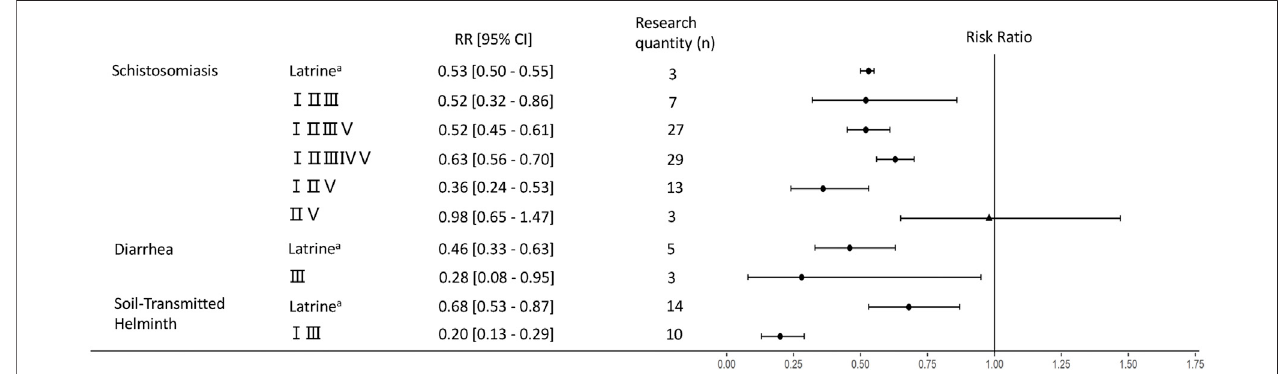
FIGURE 4 | Forest plot for latrine improvement and other interventions. Note: a indicate measures of latrine improvement; I – V correspond to the code of the intervention classi fi cation shown in Table 1 ; the fi gure shows the RR value when these measures are combined with latrine improvement measures; I refers to population-leveldiseasecontrol,IIreferstoanimalreservoircontrol,IIIreferstowatersupplyimprovements,IVreferstoagriculturalandforestrymeasures,andVrefersto othercomprehensive environmental improvement measures; round dotsin the fi gure indicate that themeasure isaprotectivefactor, and triangles indicatethat the statistical test of the measure is not signi fi cant.